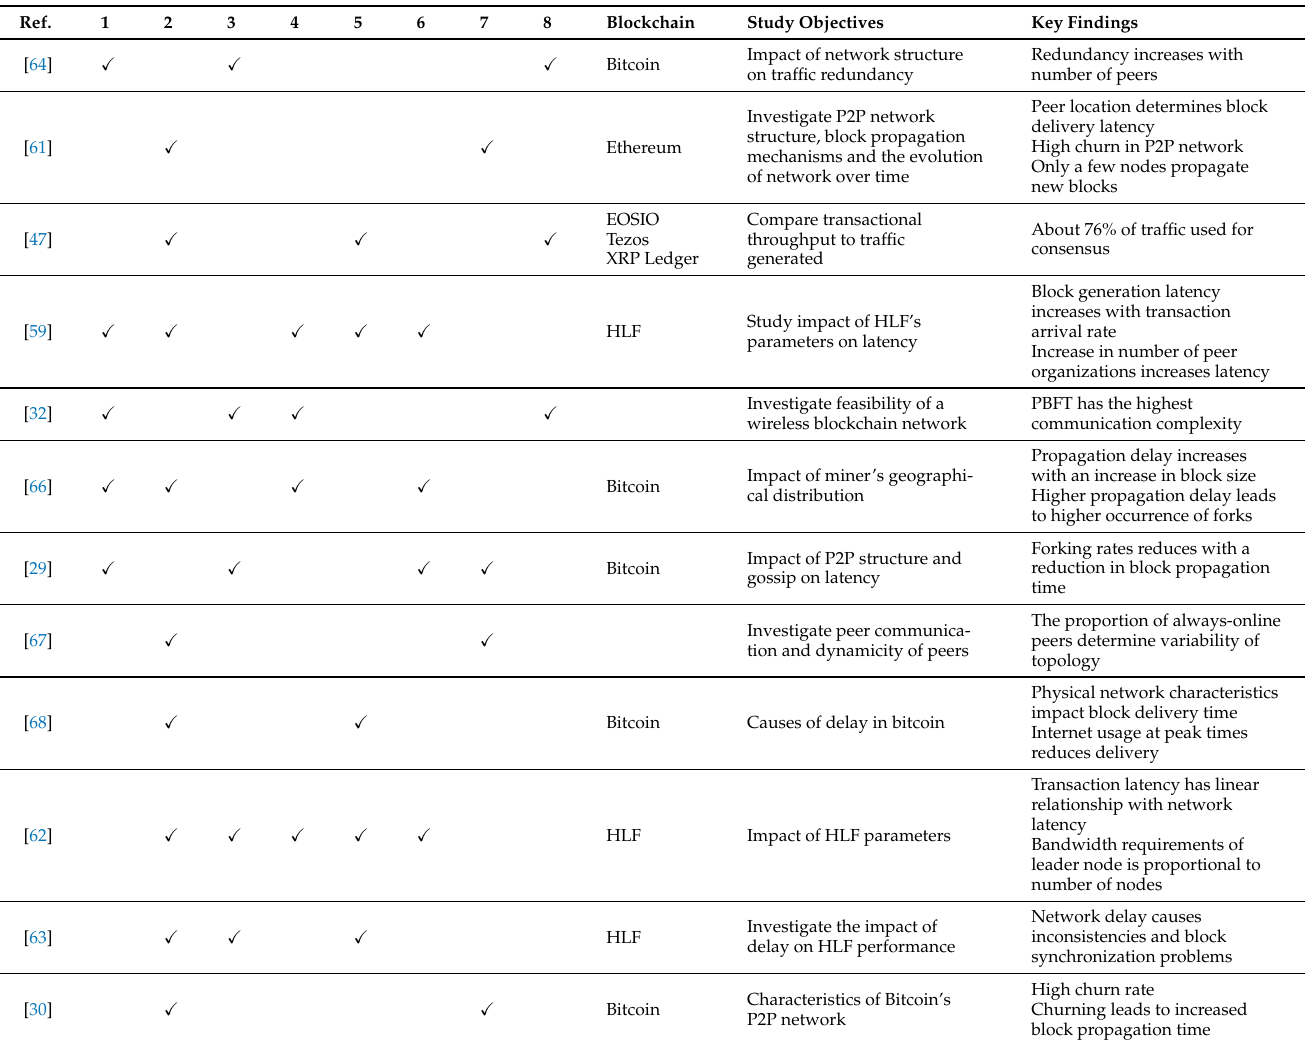
Table 5. Studies on Blockchain’s Network Characteristics 1 = Mathematical Analysis and Simu- lations, 2 = Measurement on Real Network, 3 = Varied Network Size, 4 = Varied Block Size and Interval, 5 = Analyzed Transactional Throughput, 6 = Analyzed Latency, 7 = Analyzed P2P Structure, 8 = Analyzed Traffic